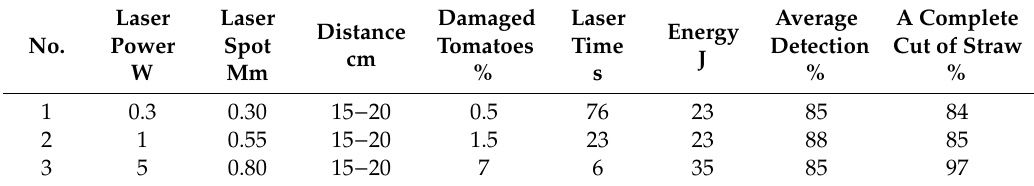
Table 3. The effect of the laser system using three different lasers for cutting 35-day-old shoots of E. repens (less than 100 mm tall). Each laser was fired approximately 200 times. Some tomatoes were also hit and left with traces on the leaves but did not kill the plants.